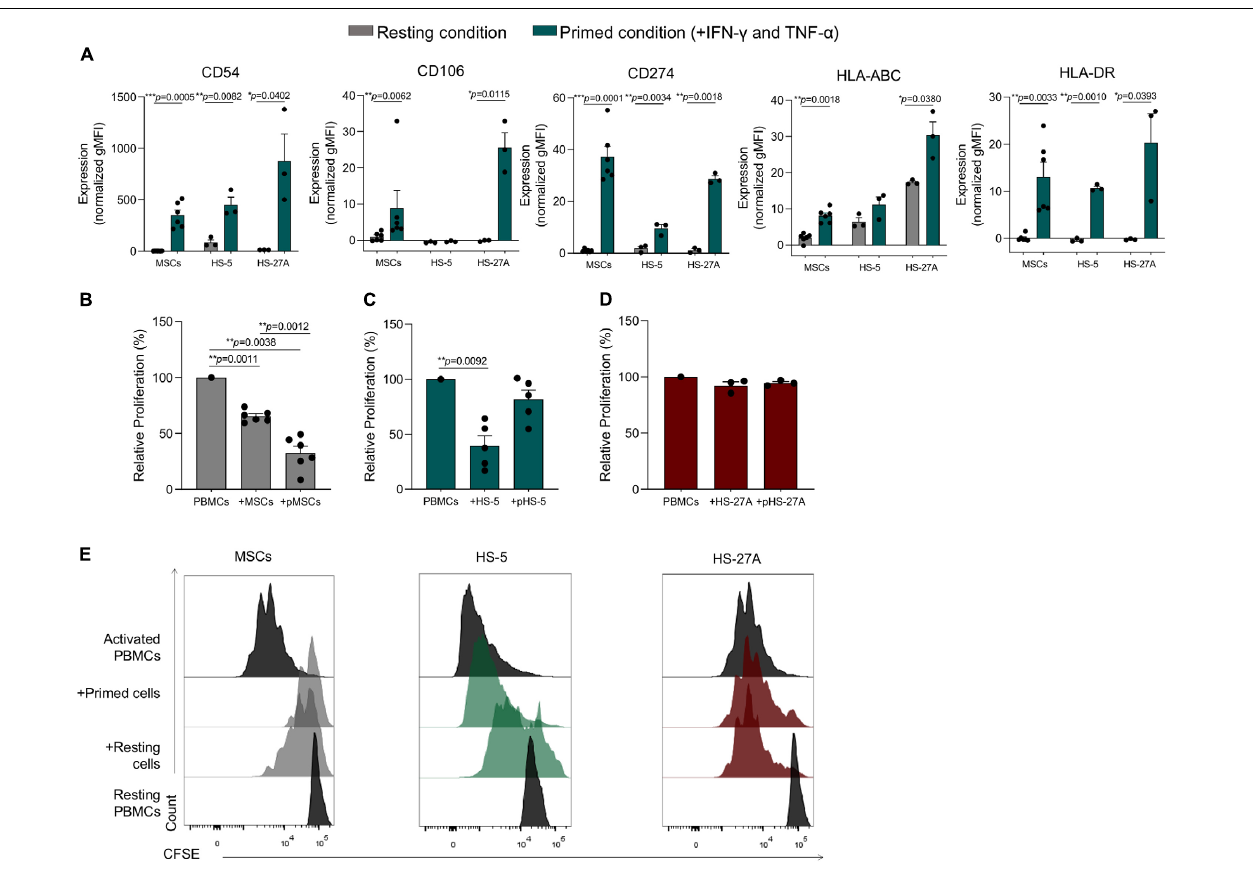
FIGURE 5 | Immunological characterization of HS-5 and HS-27A cell lines. (A) FACS immunophenotypic analysis of primary MSCs, HS-5, and HS-27A cell lines showing the expression profile of CD54, CD106, CD274, HLA-ABC, and HLA-DR in resting or primed condition. Data are represented as mean of gMFI (geometric mean fluorescence intensity) normalized on FMO (fluorescence minus one) control ± SEM. (B–D) Relative PBMCs proliferation following 4 days of co-culture with resting or primed MSCs, HS-5 or HS-27A, respectively. PBMCs proliferation was calculated on living CD45 + cells according to CFSE dilution method by measuring CFSE gMFI and normalized on activated PBMCs cultured in absence of stromal cells. Data are represented as mean ± SEM. (E) Representative proliferation peaks of living CFSE + CD45 + PBMCs following the co-culture with resting or primed MSCs (gray), HS-5 (green), and HS-27A (dark red).